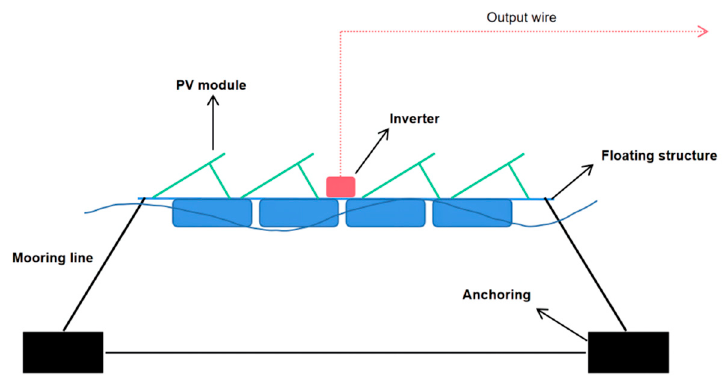
Figure 1. Main components of FPV system.